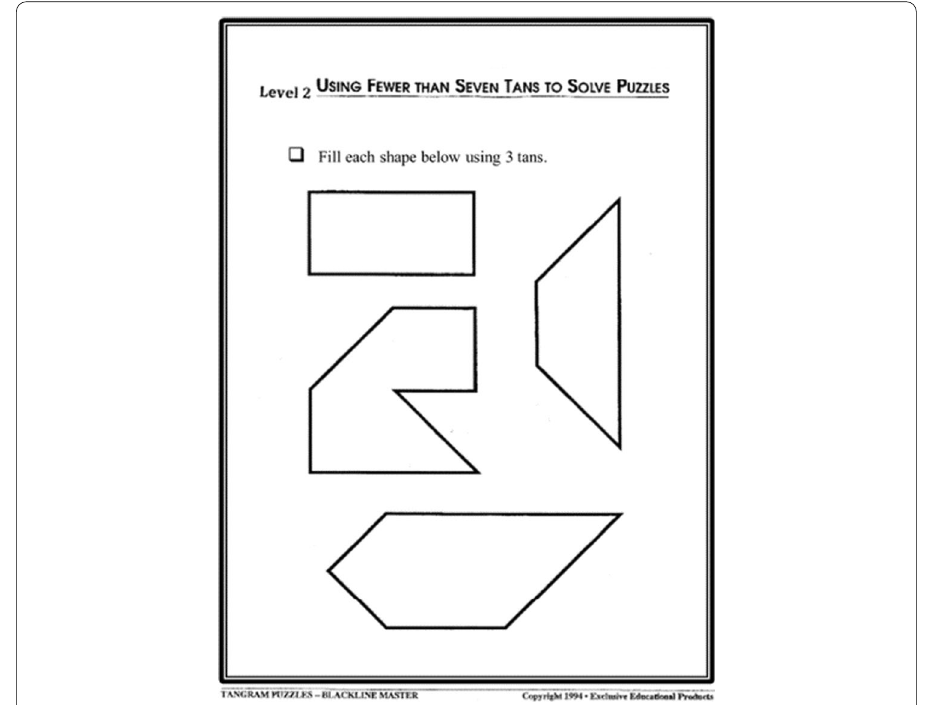
Fig. 5 Challenge Level 2 Sheet for Stage 3 taken from Tangram Blackline Masters